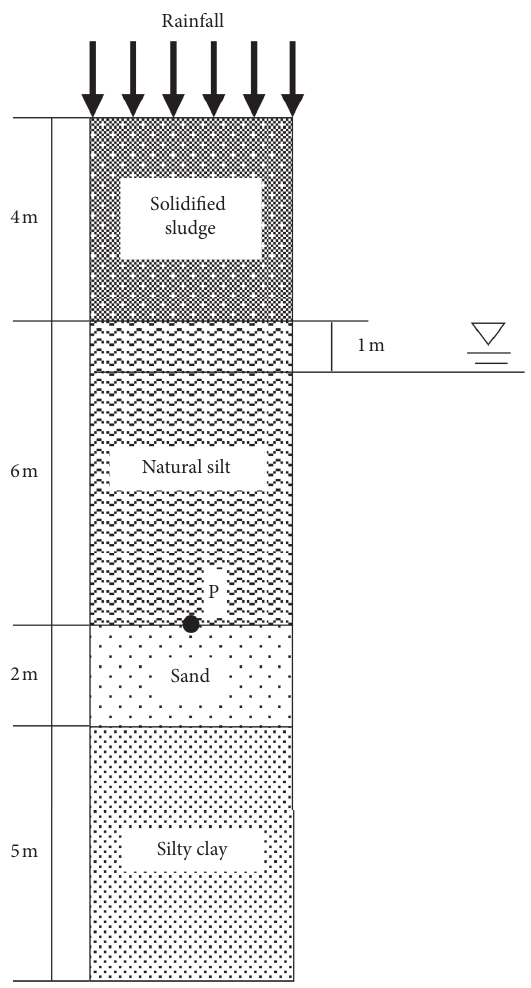
Figure 4: Schematic diagram of the calculation